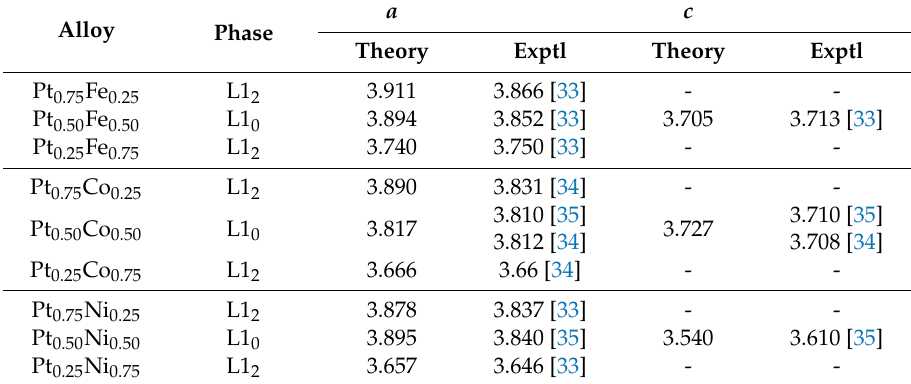
Figure 1. Structures of the ordered ( a ) L1 2 Pt 0.75 M 0.25 (M = Fe, Co or Ni) and ( b ) L1 0 Pt 0.5 M 0.5 alloys. The ordered Pt 0.25 M 0.75 alloys are formed by replacing each Pt atom with an M atom and vice versa, in the structure shown in panel ( a ). The lattice parameters a for L1 2 and L1 0 and c (for L1 0 only) are shown. Table 1. Lattice parameters determined in the current work (‘Theory’) for each of the ordered L1 2 Pt 0.25 M 0.75 (M = Fe, Co or Ni) and Pt 0.75 M 0.25 alloys and for the ordered L1 0 Pt 0.5 M 0.5 alloy together with corresponding experimental values (‘Exptl’). The lattice parameters a and c are defined in Figure 1. All dimensions are in